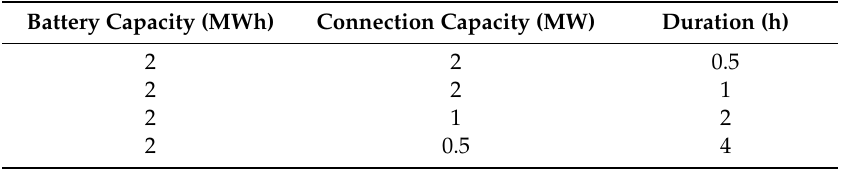
Table 1. Capacity market battery de-rating factors used in this study.